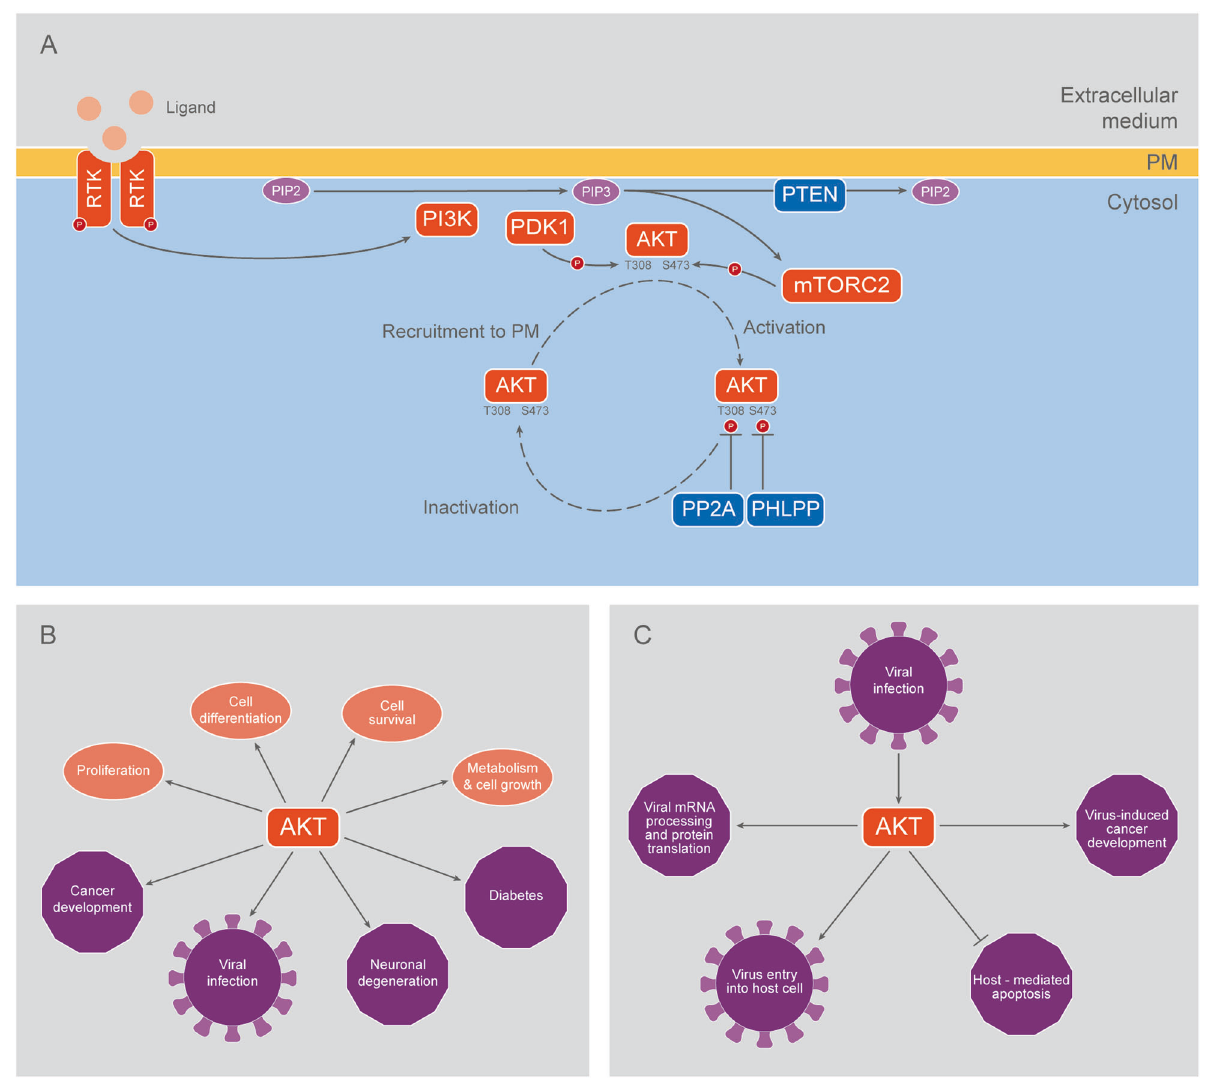
Fig. 1 The AKT pathway. A A traditional perspective of AKT activation assumes that PI3K, which converts PM-associated PIP2 to PIP3 in response to Growth Factors (GF) and other stimuli, leads to PIP3-mediated recruitment of cytosolic AKT to PM. The conformational change elicited by AKT PH domain binding to PIP3 allows phosphorylation of AKT by PDK1 and mTORC2. As a result, activated AKT concertedly regulates a great variety of targets and functions in the cytosol and the nucleus, among other subcellular compartments. B Examples of physiological and pathological processes in which AKT is implicated. C Key steps of viral infection regulated by